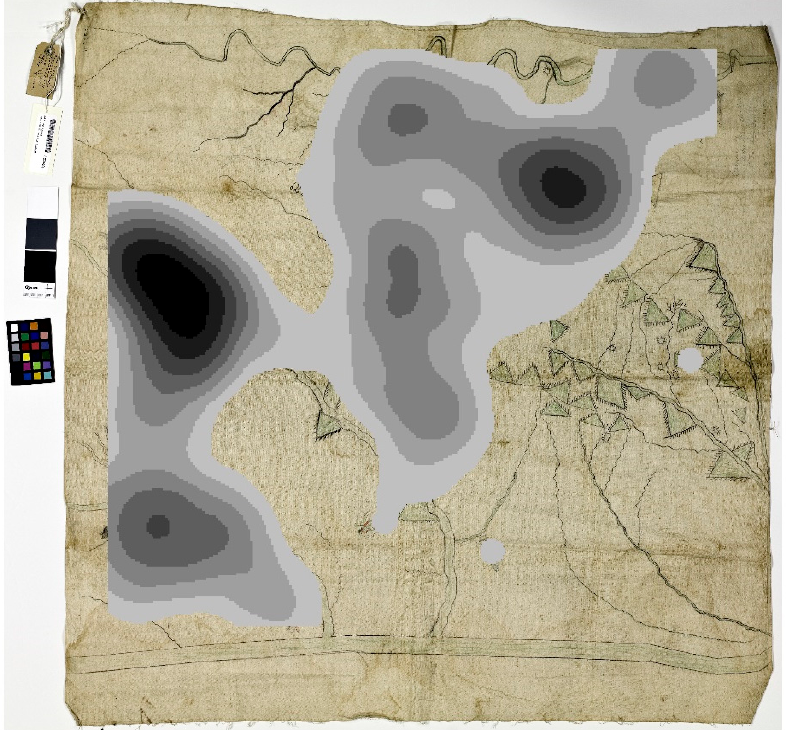
Figure 4. Map showing the density of pictorial image locations on the Kiowa map. Source: Mark Palmer, University of Missouri, Department of Geography.